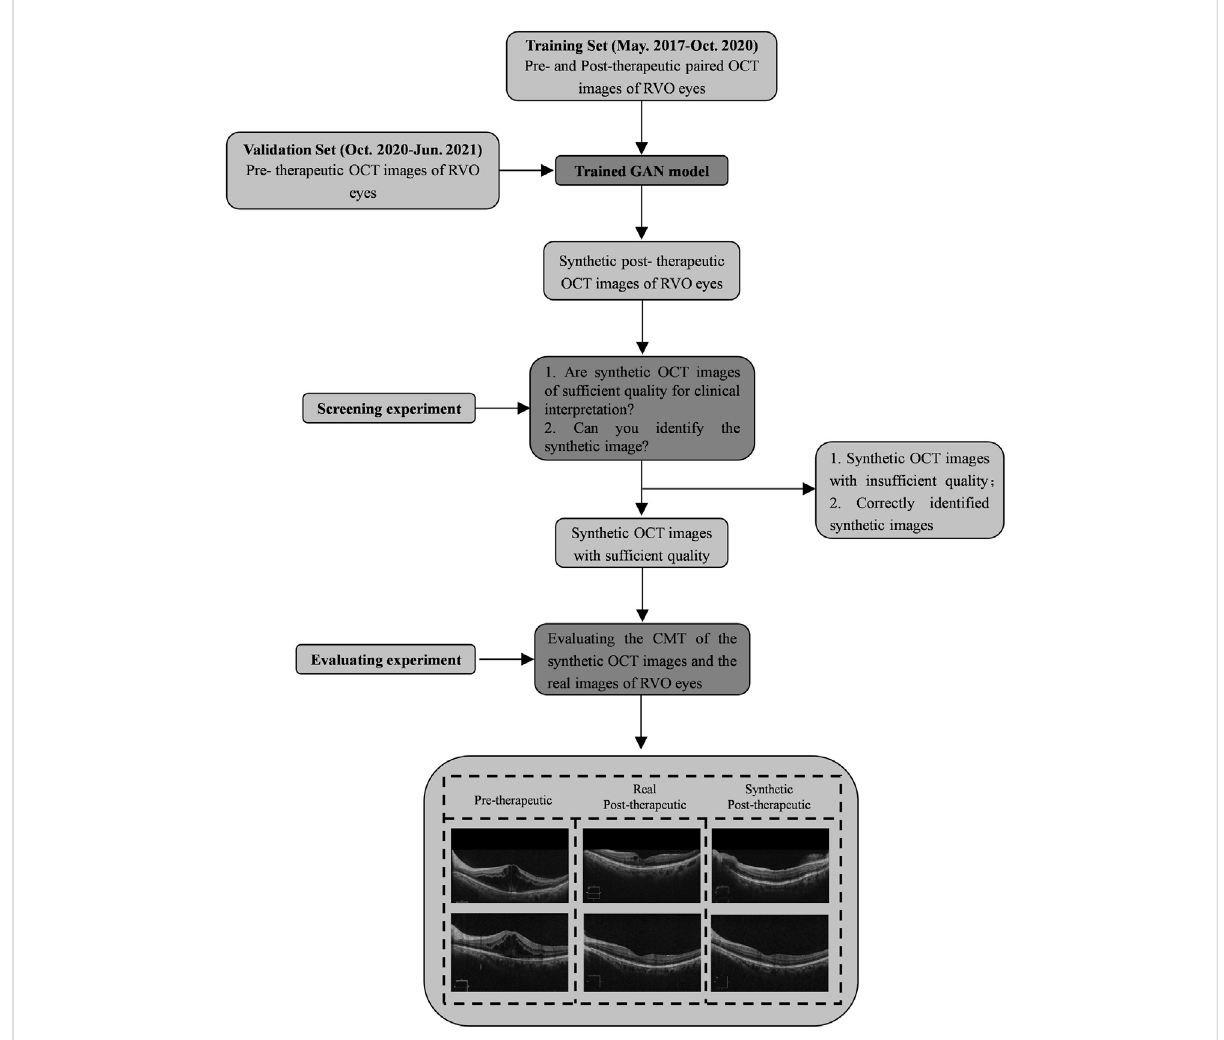
FIGURE 3 Work fl owofevaluating themodelperformance.OCT,opticalcoherence tomography; RVO,retinal veinocclusion; GAN,generativeadversarial networks; CMT, central macular